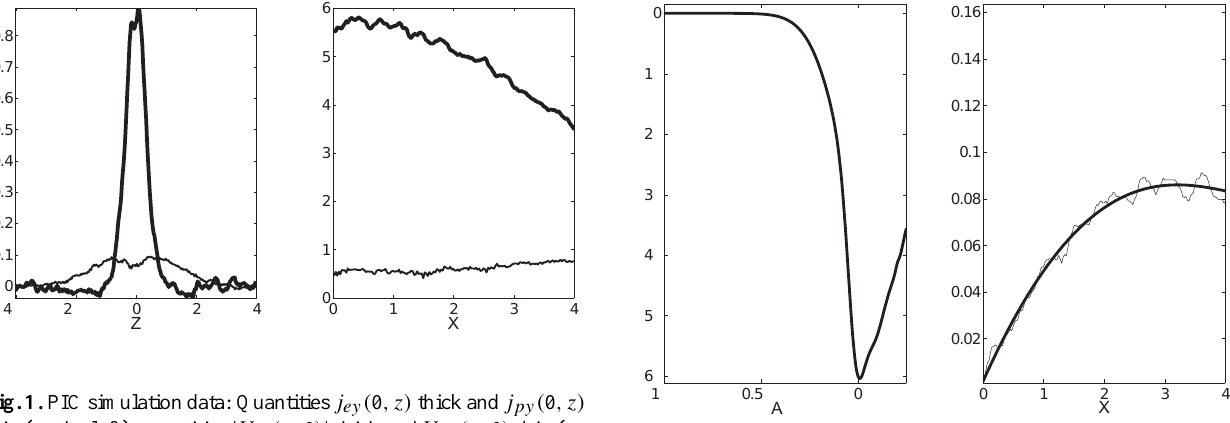
Fig. 1. PIC simulation data: Quantities j ey ( 0 ,z) thick and j py ( 0 ,z) thin (on the left); quantities | V ey (x, 0 ) | thick and V py (x, 0 ) thin (on the right).